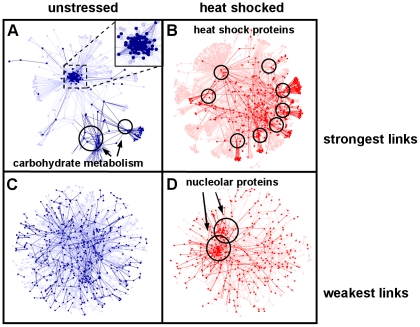
Changes of yeast interactome subnetworks after heat shock.Unstressed (panels A and C; blue) and stressed (15 min heat shock at 37°C, panels B and D; red) BioGRID yeast protein-protein interaction networks were created as described in Materials and Methods. Their subnetworks were derived from links having their interaction weights in the top (strongest links), or bottom (weakest links) 4% of all interactions. Interaction weights of the top or bottom 1% of all interaction weights and nodes having at least one of these ‘top 1%’ interactions were labeled with darker colors. The giant components of these subnetworks were visualized using the spring-embedded layout of Cytoscape [70]. Panels A and B. Strongest interactions of unstressed (A) and heat shocked (B) yeast interactome. The inset of Panel A shows the structure of the highly-connected ribosomal protein complex in more detail. Circles of Panel B highlight the following heat shock proteins in clockwise order starting from middle left: Hxt7, Ubi4, Tsl1, Ssa2, Hsp104, Adh1, Tdh3 and Hxk1. Panels C and D. Weakest interactions of unstressed (C) and heat shocked (D) yeast interactome.